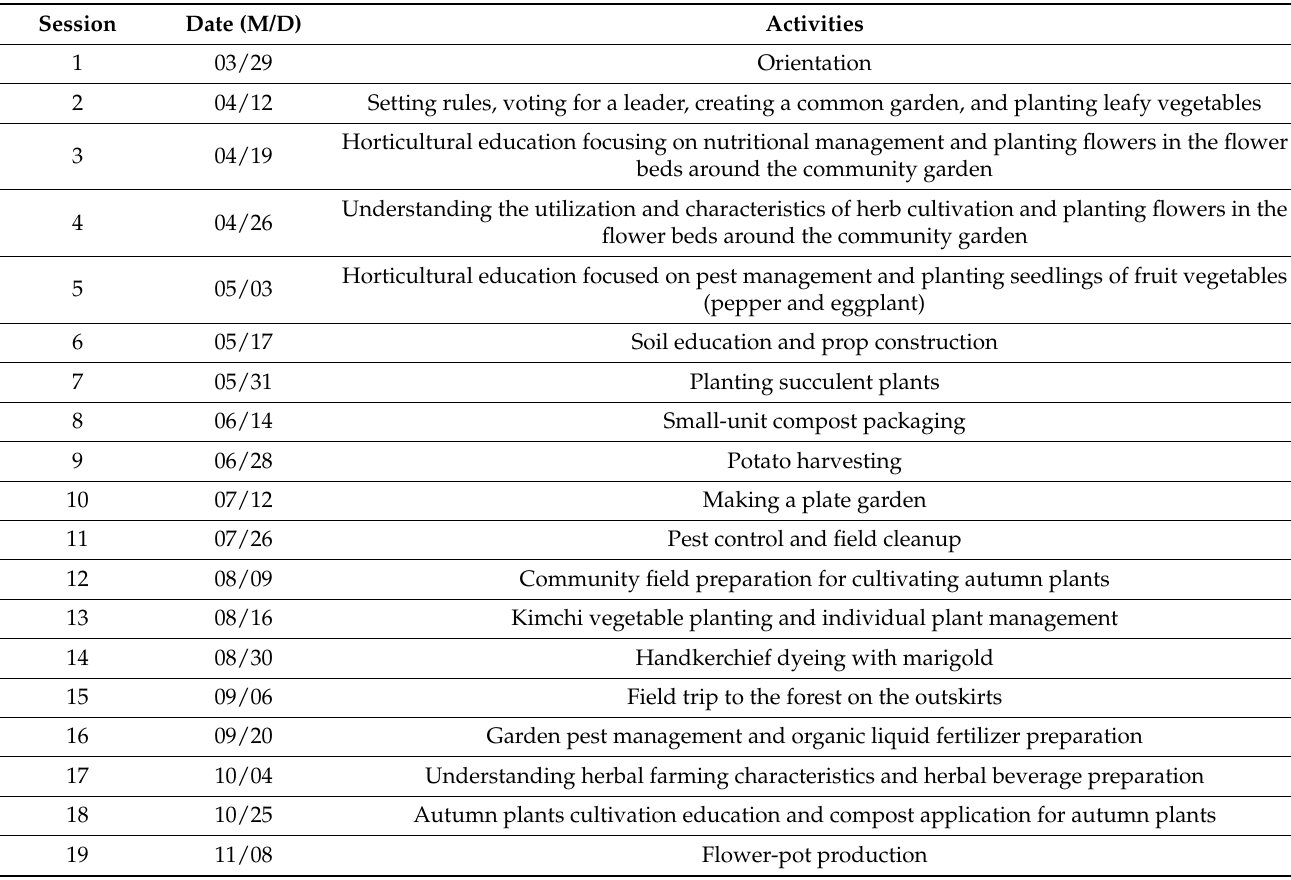
Figure 5. Snapshots showing the process of the HEG program. HEG: group participating in the apartment community garden program with a focus on horticultural education. Table 5. The HEG program.